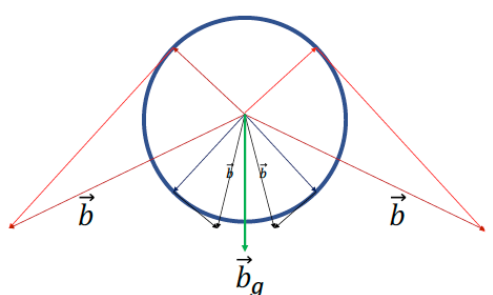
Figure 4. Vector (cid:126) b g which is pointing in the direction of increasing gravitational force. The right angle triangles show vector addition as expressed by solution, (cid:126) L 2 = (cid:126) b = u ∗ r ∗ (cid:126) e r ∗ + u ∗